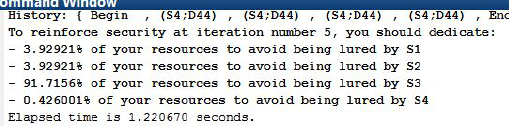
Figure 10. Case N o 3: